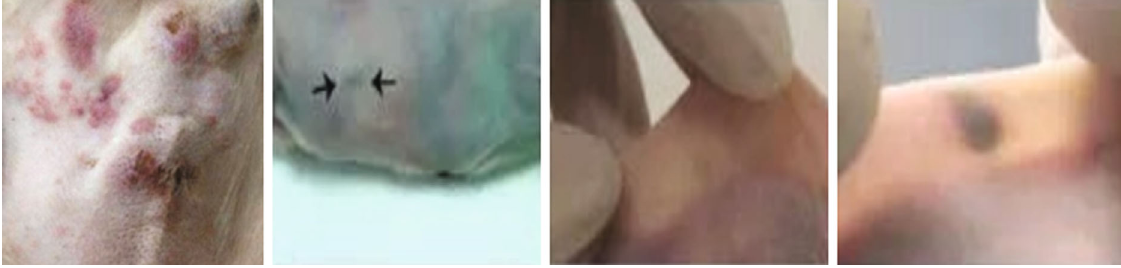
Figure 2: Images of mouse cutaneous MM models.